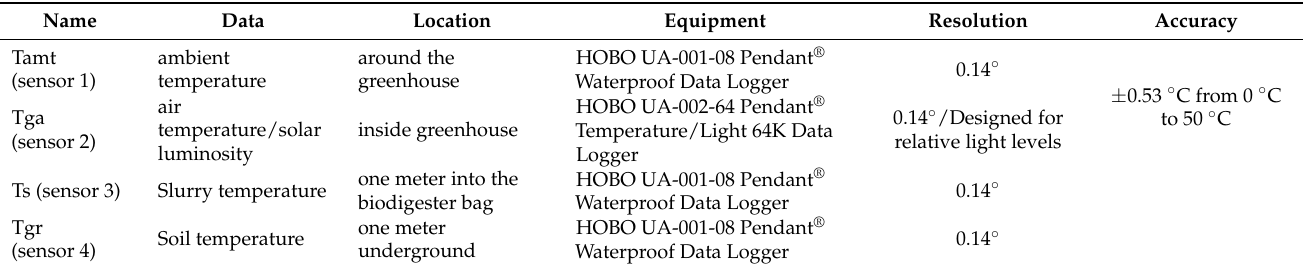
Figure 1. Digester scheme and location of temperature sensors. Table 1. Location and characteristics of temperature sensors.